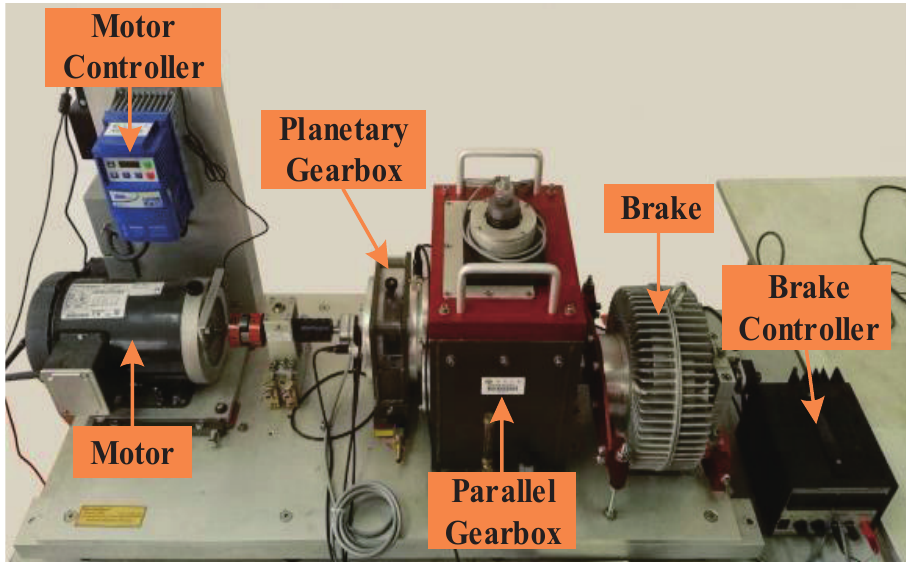
Figure 4. Experimental setup for gearbox dataset. Table 2. The specific channels and corresponding sensor signals of SEU. Location Type Description Chipped Crack occurs in gear feet Miss Gearbox Root Crack occurs in root of gear feet Wear occurs in surface of gear Ball Crack occurs in the ball Inner Crack occurs in inner Bearing Outer Crack occurs in outer